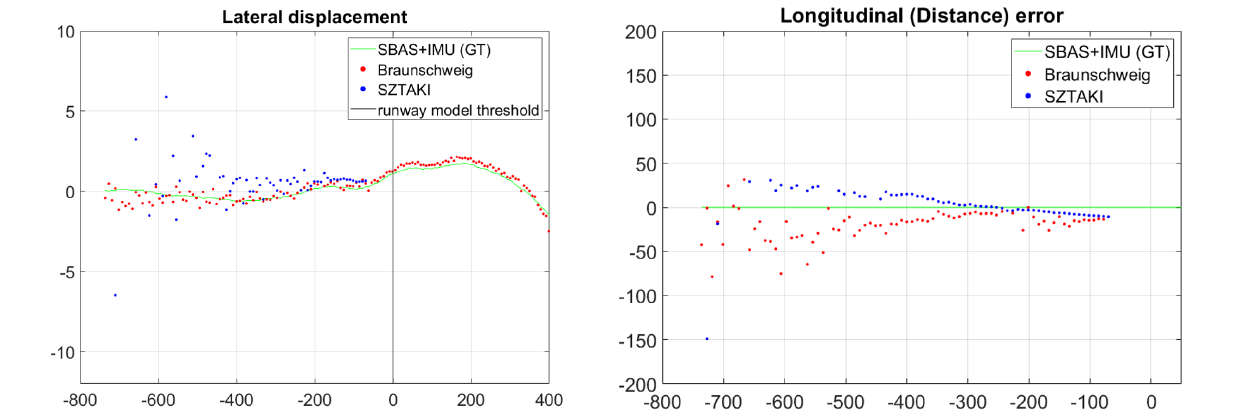
Figure 17. Lateral displacement according to distance from runway and the error of distance measurements. Threshold markers are no longer visible within 60 m because the camera looks ahead of the markers, however, lateral displacement can be calculated with center line and side line detection.